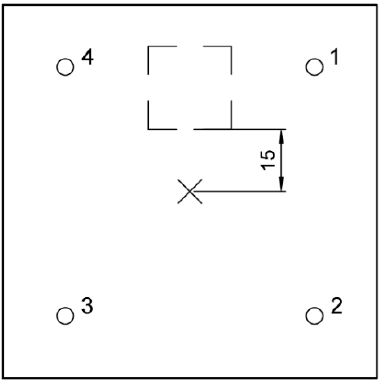
Figure 15. Scheme of void and IE device layout, edge 15 cm from impactor.